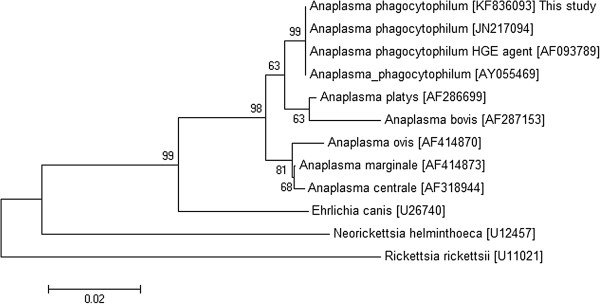
Phylogenetic dendrogram of Anaplasma phagocytophilum isolated from dogs and ticks based on 16S rRNA gene sequence comparison (420 bp). GenBank accession numbers are shown in parentheses. The tree was constructed using the neighbor-joining method and numbers above internal nodes indicate the percentages of 1,000 bootstrap replicates that supported the branch.